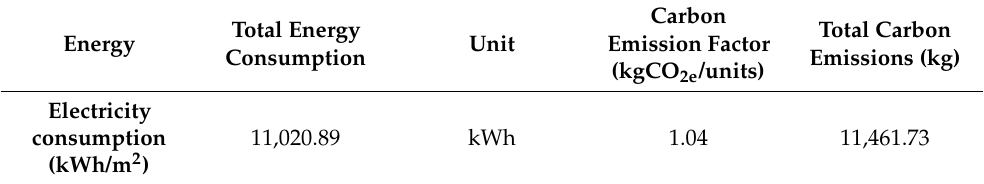
Table 7. On-site transportation carbon